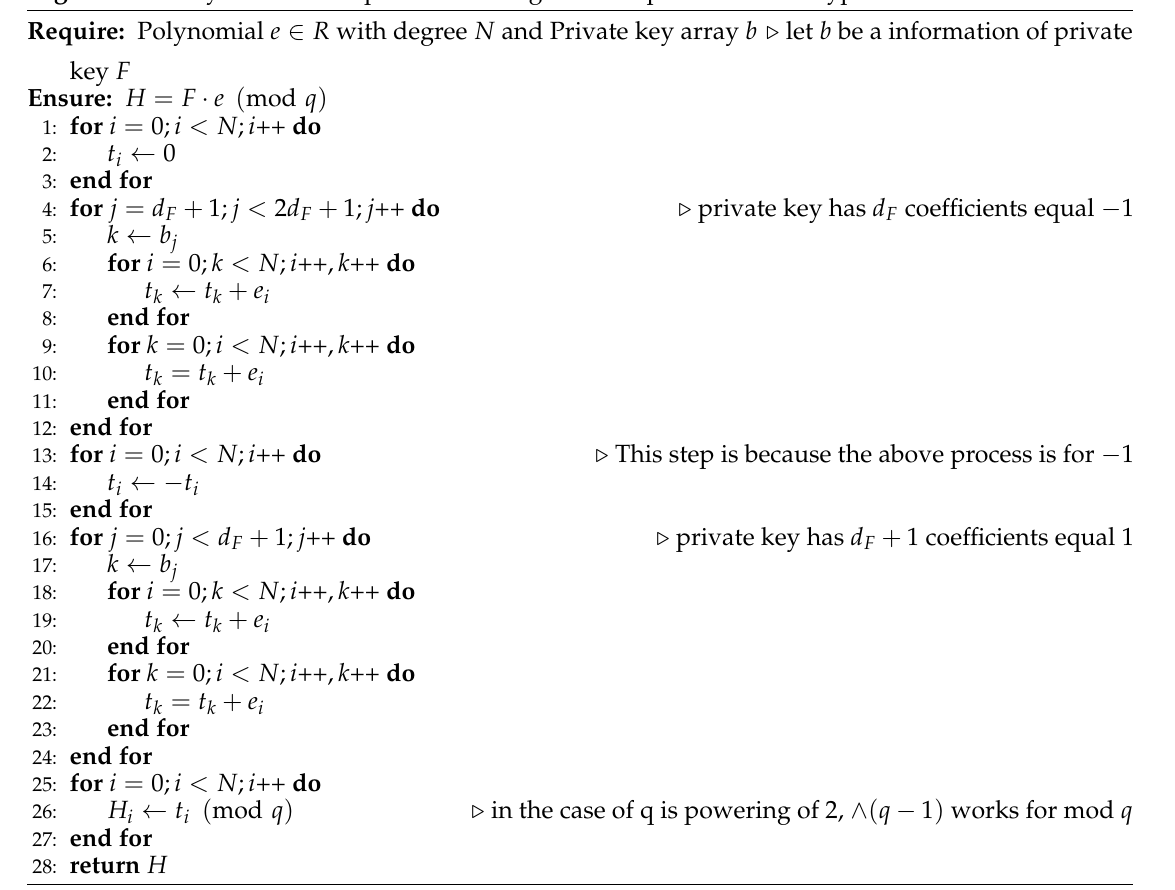
Algorithm 2 Polynomial Multiplication during NTRU Open Source